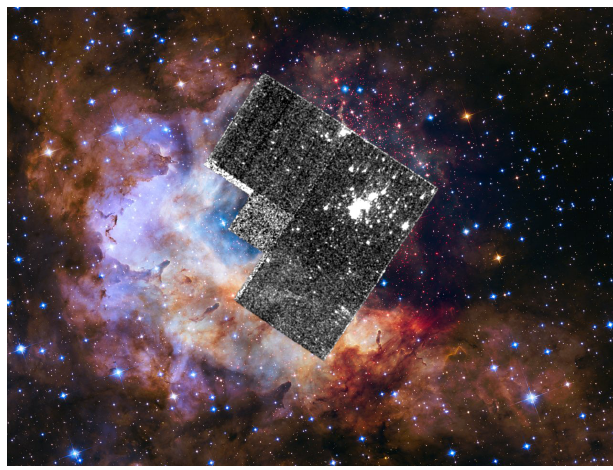
Fig. 5.— Image credit: NASA, ESA, the Hubble Heritage Team (STScI/AURA), A. Nota (ESA/STScI), and the Westerlund 2 Sci- ence Team the footprint of the WFPC3. In fact, the WFPC3 in- set is already a blend of four images, created from the three image chips (CCDs) of the Wide Field Camera (the three larger squares) and the image chip of the Planetary Camera (smaller square nestled into the corner formed by the other three).